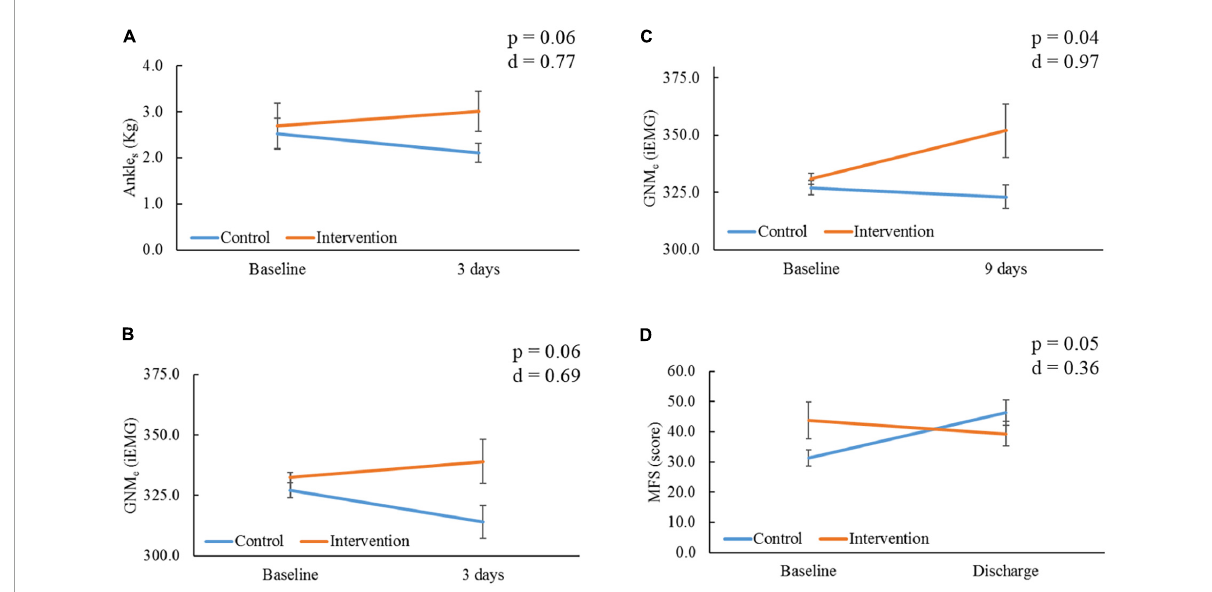
FIGURE4 Comparison of outcomes within and between groups through time. Ankle s , ankle strength; kg, kilograms; GNM e , gastrocnemius muscle endurance; iEMG, integrated electromyography unit; MFS, Morse Fall Risk Scale. (A) Comparison of Ankle s , and (B) GNM e within and between groups at 3 days from baseline. (C) Comparison of GNM e within and between groups at 9 days from baseline. (D) Comparison of MFS within and between groups at the time of intensive care unit (ICU) discharge (18.00 ± 10.19 days) from baseline; severity is proportional to high score. P -value and Cohen’s d effect size are noted from time group interaction at each determined time point.